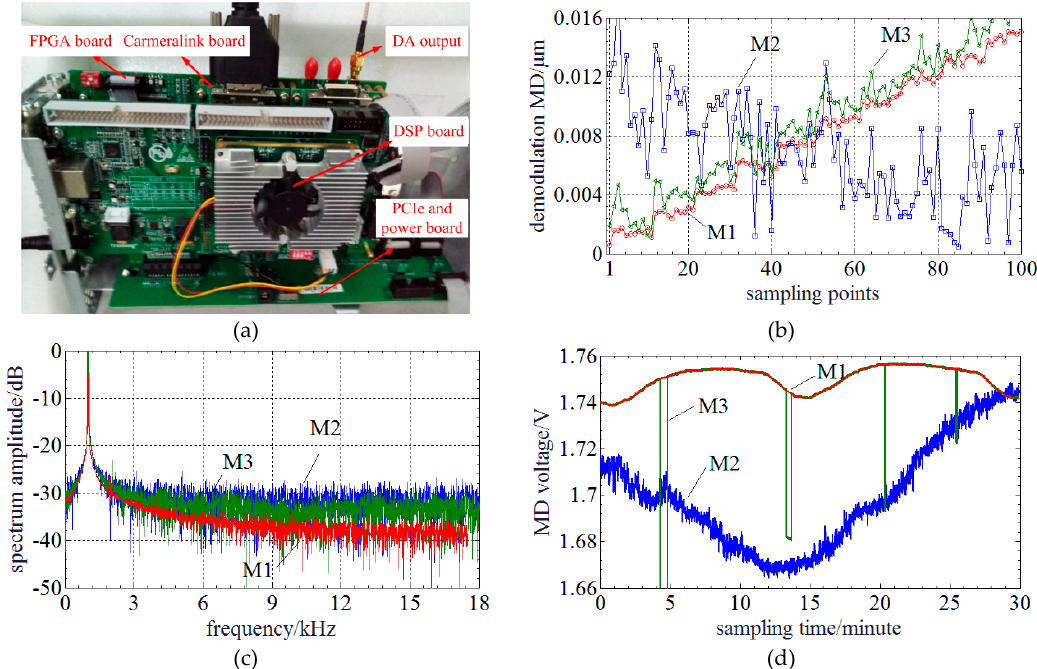
Figure 10. Experimental results of performance tests: ( a ) Photography of the embedded processing system; ( b ) Resolution test; ( c ) Harmonic spectrum of the frequency response test; (d) Stability test within 30 minutes (M1, M2 and M3 respectively represents the proposed method, envelope method and Wang’s method).